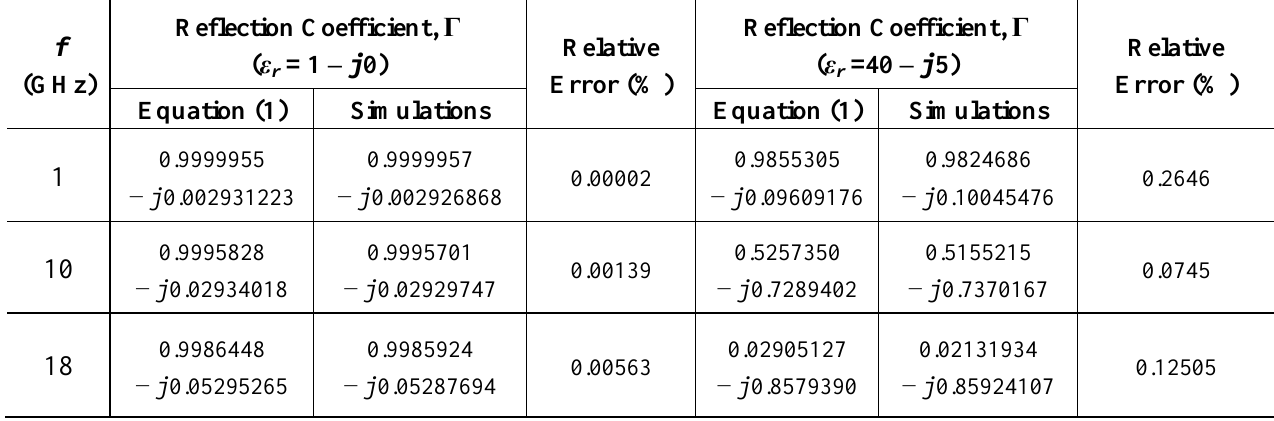
Table 2. Calculated and Simulated Reflection Coefficient,